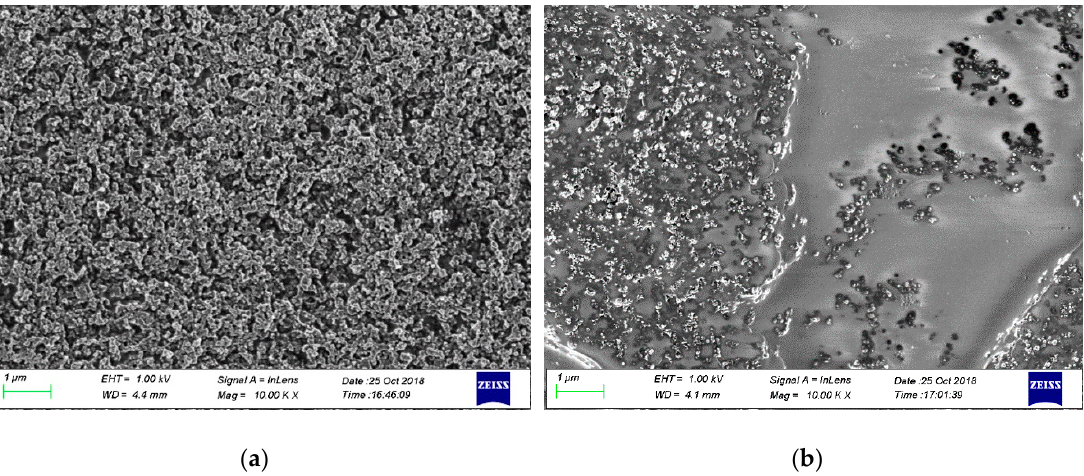
Figure 2. ( a ) EC-CB and ( b ) PS-CB electrode surfaces analyzed by SEM. Magnification of 10,000